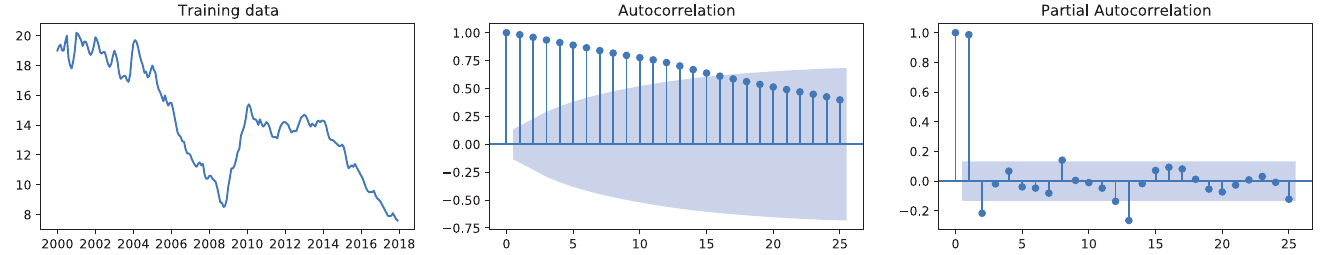
Figure 7. Training data, ACF and PACF plots for